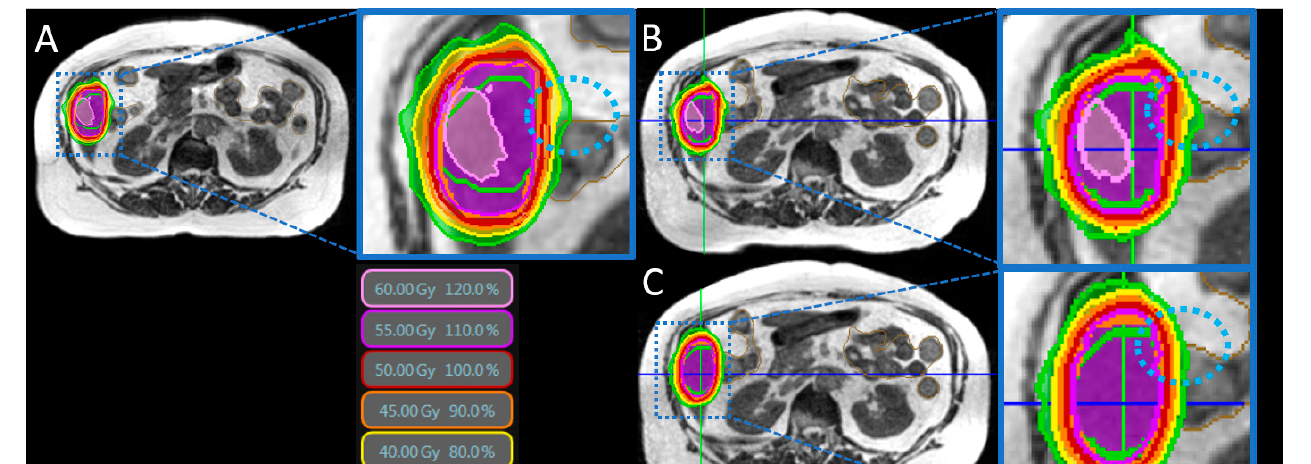
Figure 1. Case study. ( A ) Baseline plan (50 Gy in 10 fractions) with already slightly impaired PTV coverage (91%) due to proximity to the intestines (brown). ( B ) Daily online MRI-guidance revealed that the small bowel had moved slightly forward in ventral direction (dashed light-blue circle) leading to a predicted plan with excessive dose in the small bowel together with impaired PTV coverage (78 %). ( C ) Plan adaption led to the removal of the dose bulge (dashed light-blue circle) and resulted into superior sparing of the small bowel, while simultaneously improving PTV coverage (90%).